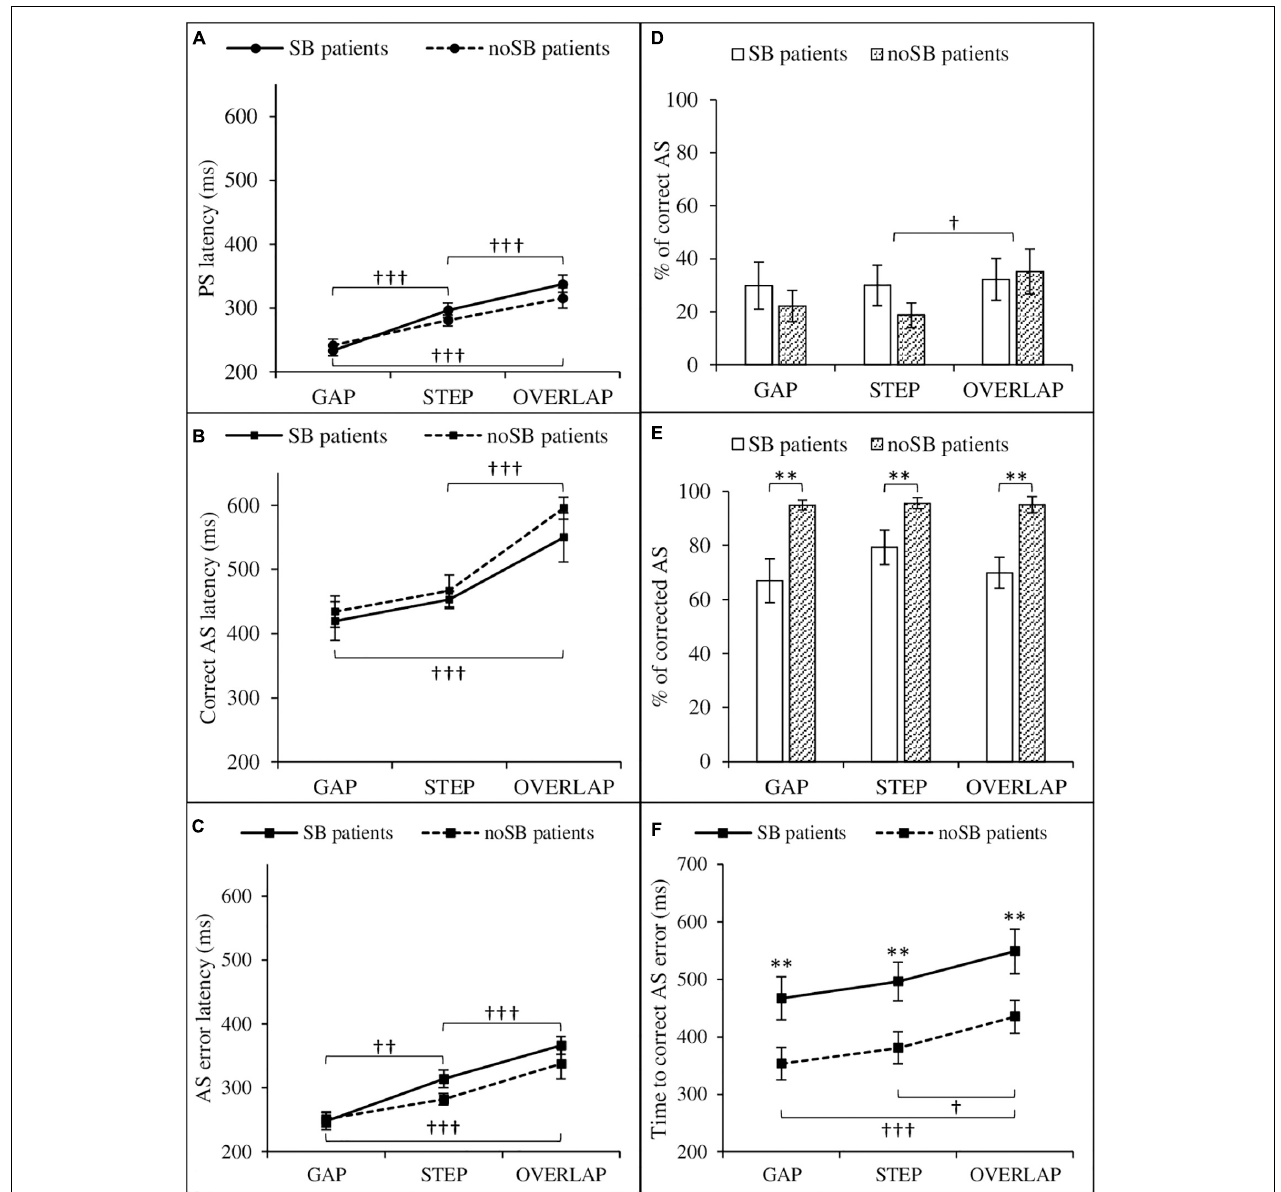
FIGURE 2 | Saccadic eye movement parameters as a function of condition (gap, step, and overlap) and patient group (SB patients and no SB patients). Left: prosaccades (A) , correct antisaccades (B) , and antisaccade errors (C) latencies. Right: proportion (i.e., percentage of the total number of saccades) of correct antisaccades (D) , proportion of corrected antisaccades among antisaccade errors (E) , time to correct antisaccade errors (F) . AS, antisaccade; no SB, no suicidal behaviors; PS, prosaccade; SB, suicidal behaviors. Error bars: ± 1 standard errors. Significant differences between condition are represented by “ † ” ( † p < 0.05; †† p < 0.01; ††† p < 0.001). Significant differences between patients with SB and patients with no SB are represented by “ ∗ ” ( ∗∗ p < 0.01).